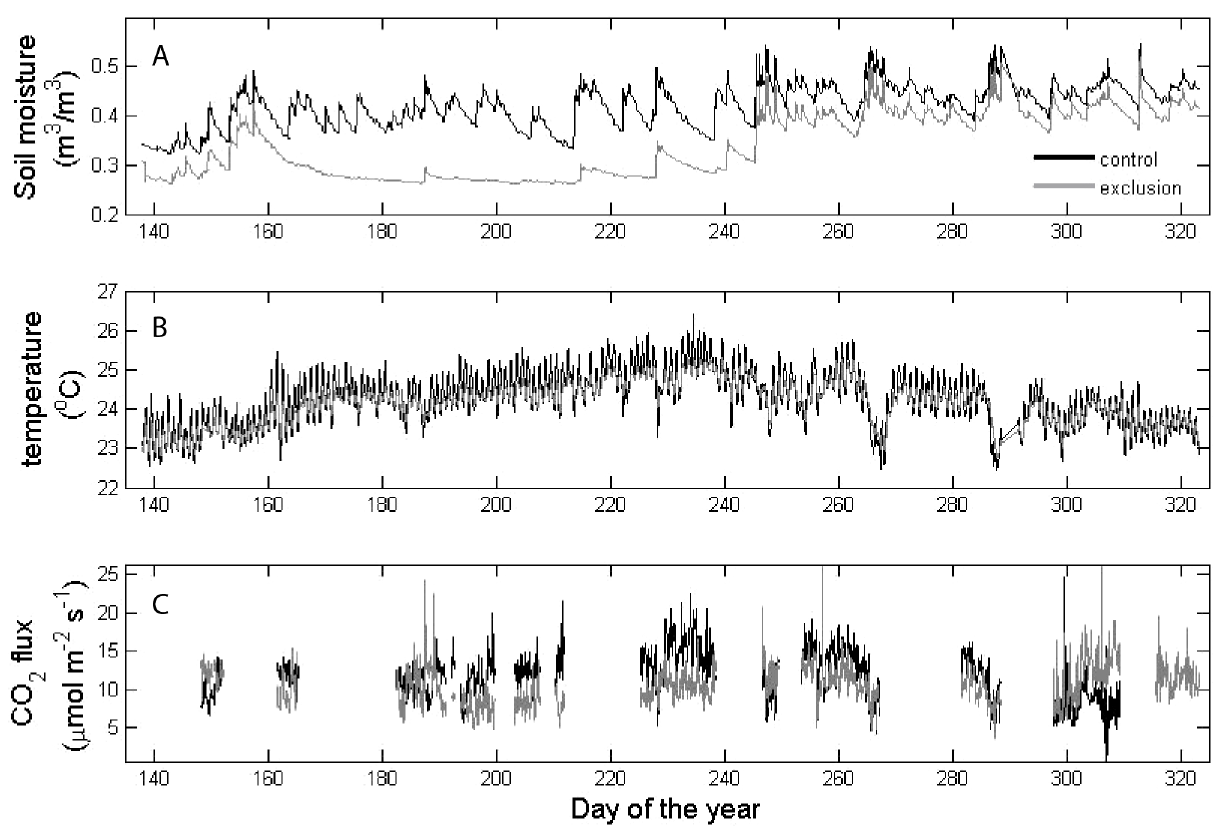
Figure 2. Time series for (A) soil moisture, (B) soil temperature, and (C) carbon dioxide (CO 2 ) flux over the 6-month study (June through December 2008) in the control (black) and exclusion (gray) plots. Throughfall exclusion shelters were in place from June through August (3-months).